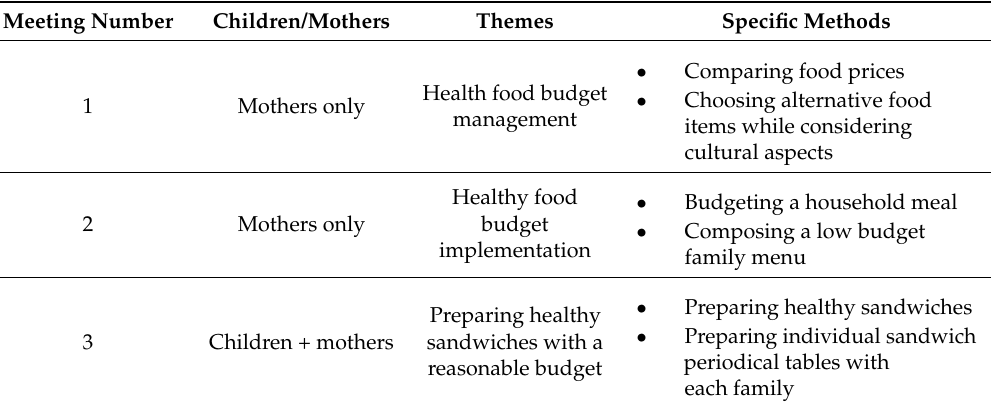
Table A3. Mothers’ intervention (full model